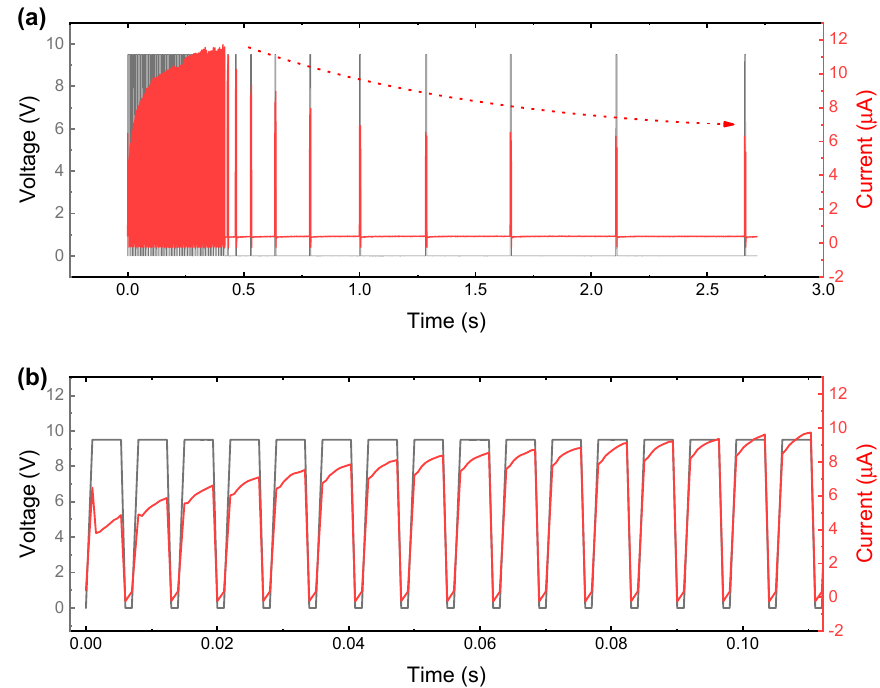
Figure 3. ( a ) Accumulation and decay characteristics of Pt/HfO 2 /TaO x /TiN RRAM device by pulse inputs. ( b ) Initial 15 pulses with progressively increasing current.